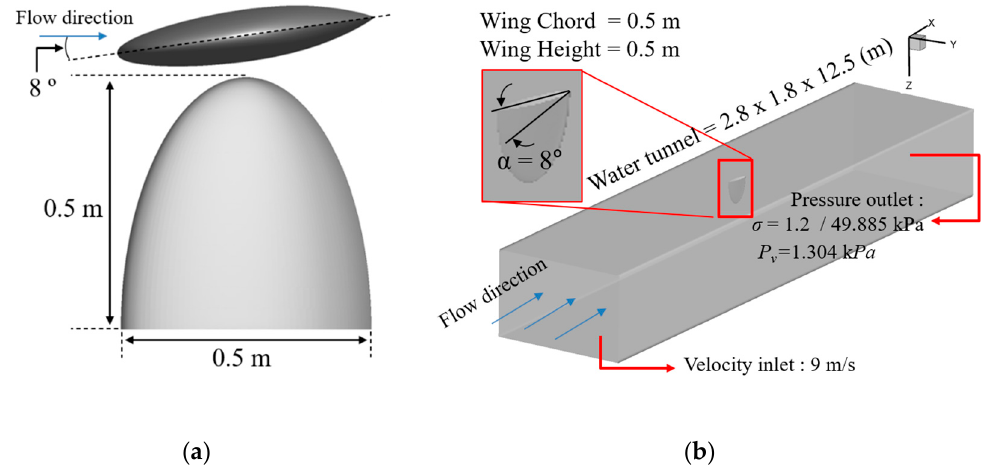
Figure 2. ( a ) NACA 16-020 wing geometry; ( b ) computational domain, boundary conditions, and targeted wing.